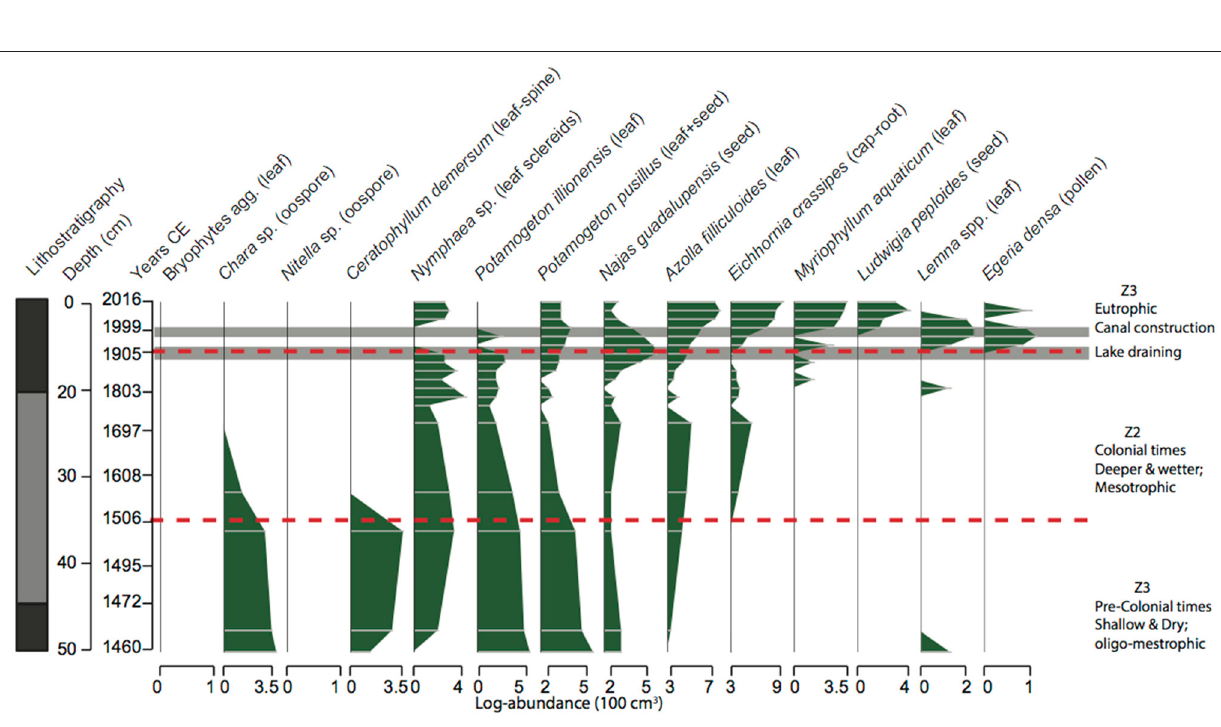
FIGURE 6 | Lithostratigraphy profile (dark gray, organic rich sediments; pale gray, low organic sediments) and plant macrofossil stratigraphy for the core LFUQ-WH1. Dotted lines represent zones of macrophyte change revealed by univariate regression tree analysis. Z1 CE c.pre-1506 CE; Z2 CE 1506-1904 CE; Z3 1905 CE